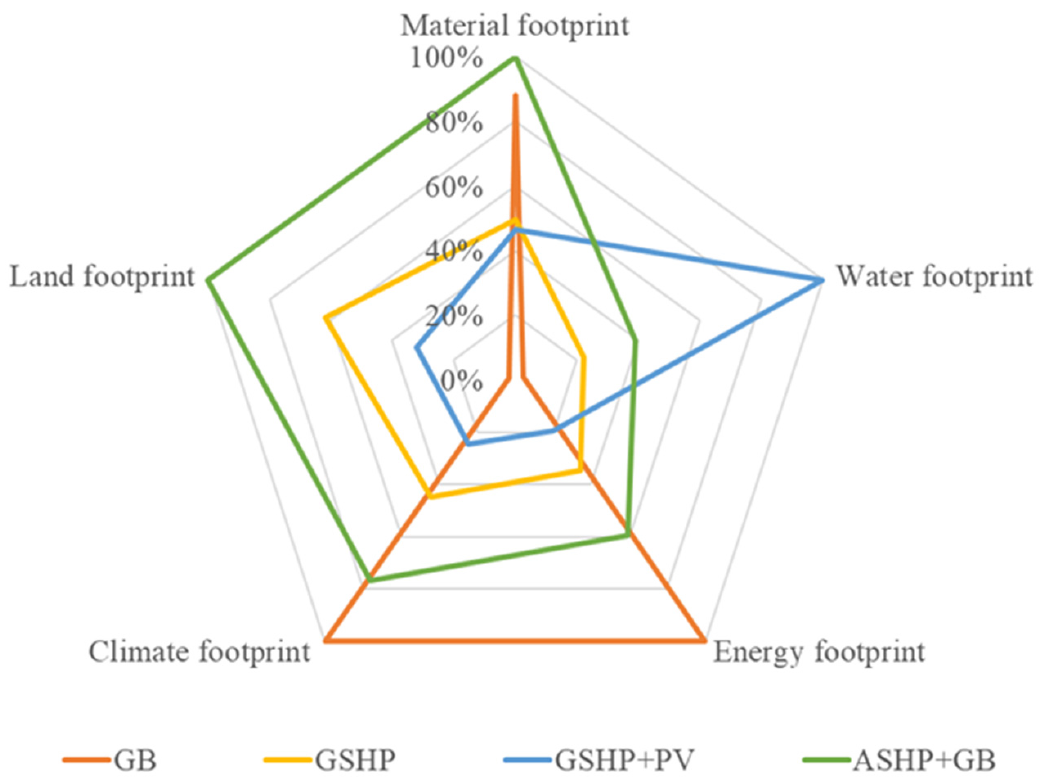
Figure 6. Relative resource and climate footprints of the heating systems. Notes. GB: Gas boiler, GSHP: Ground-source heat pump, GSHP + PV: Ground-source heat pump with a photovoltaic system, ASHP + GB: Air ‐ source heat pump backed up with a gas boiler.